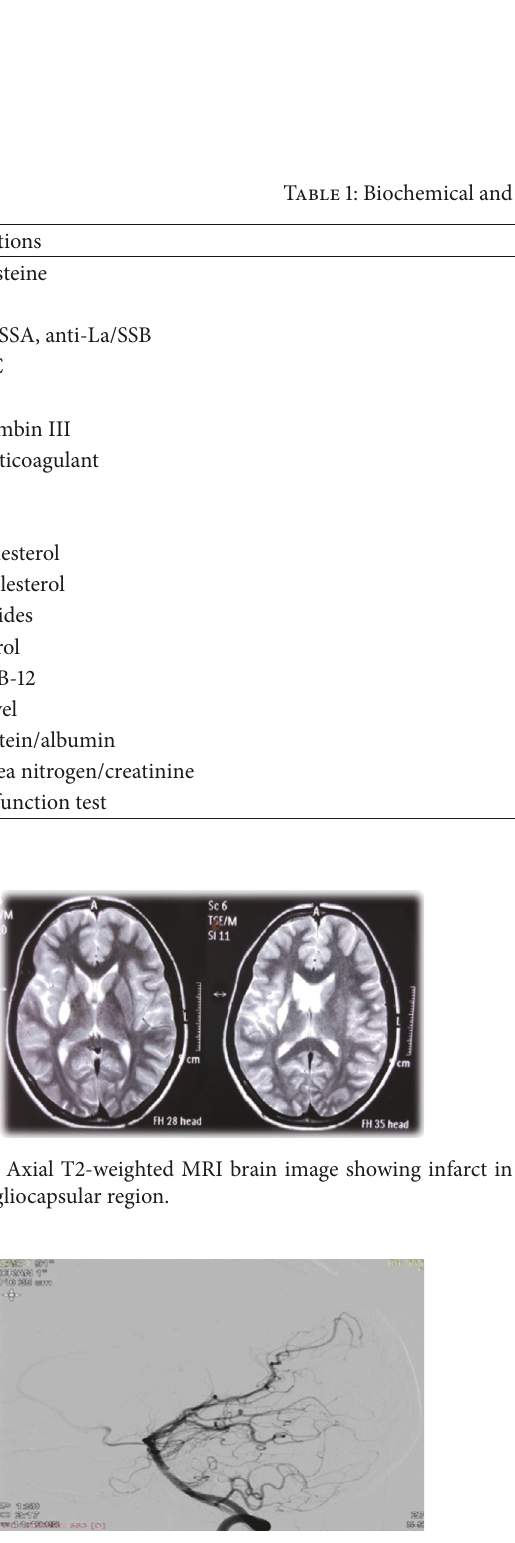
Figure 2: Vertebral angiogram image showing near total to com- plete occlusion of right M1 (MCA) just distal to origin with distal M1 reforming via perforators.